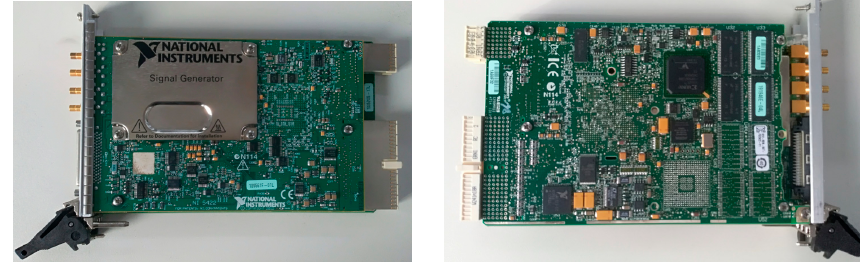
Figure 12. Hardware architecture of arbitrary waveform and signal generator.